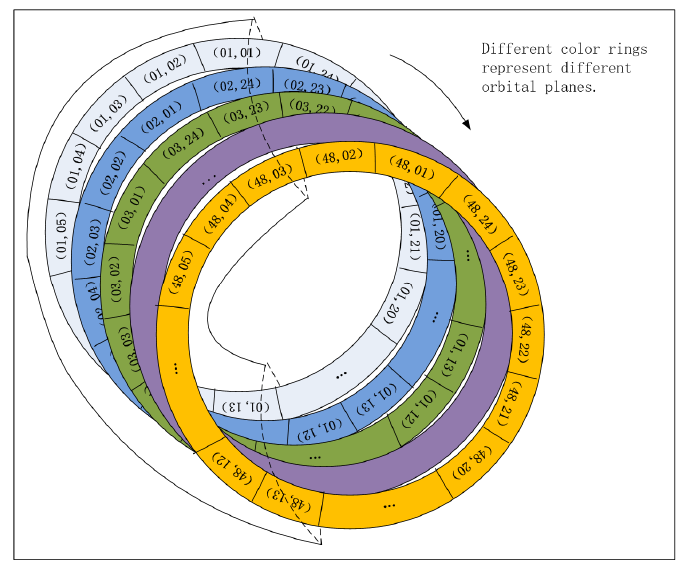
Figure 6. Charging prediction model for constellation.